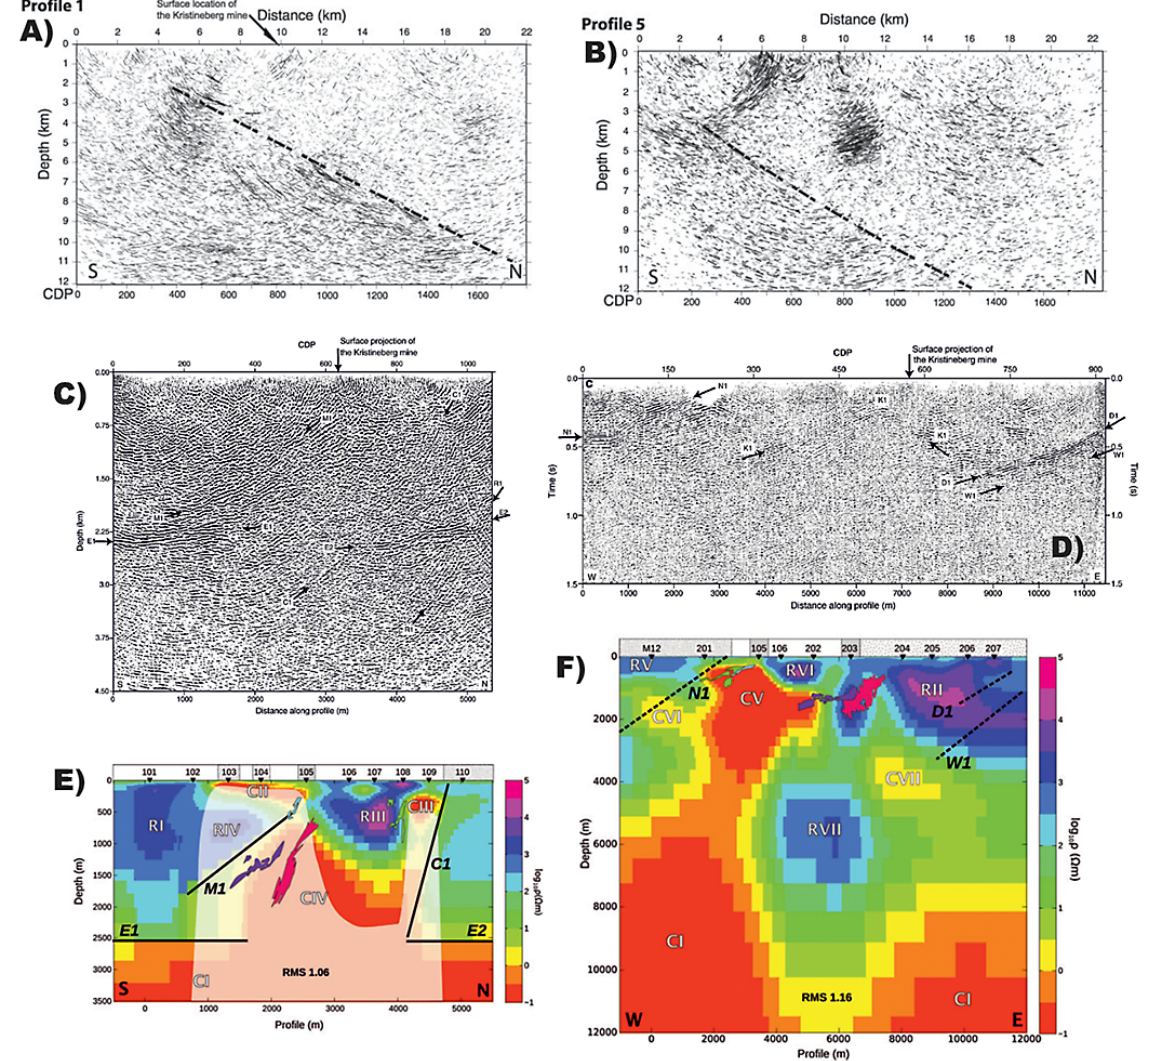
Fig. 4. Existing seismic reflection and MT profiles from the Kristineberg area, see Fig. 2a for locations. (a) and (b) Profiles 1 and 5 from Tryggvason et al. (2006). (c) and (d) high-resolution and Profile 2 from Dehghannejad et al. (2010). (e) and (f) MT profiles from García Juanatey et al. (2013); the black lines refer to seismic reflectors in (c) and (d)